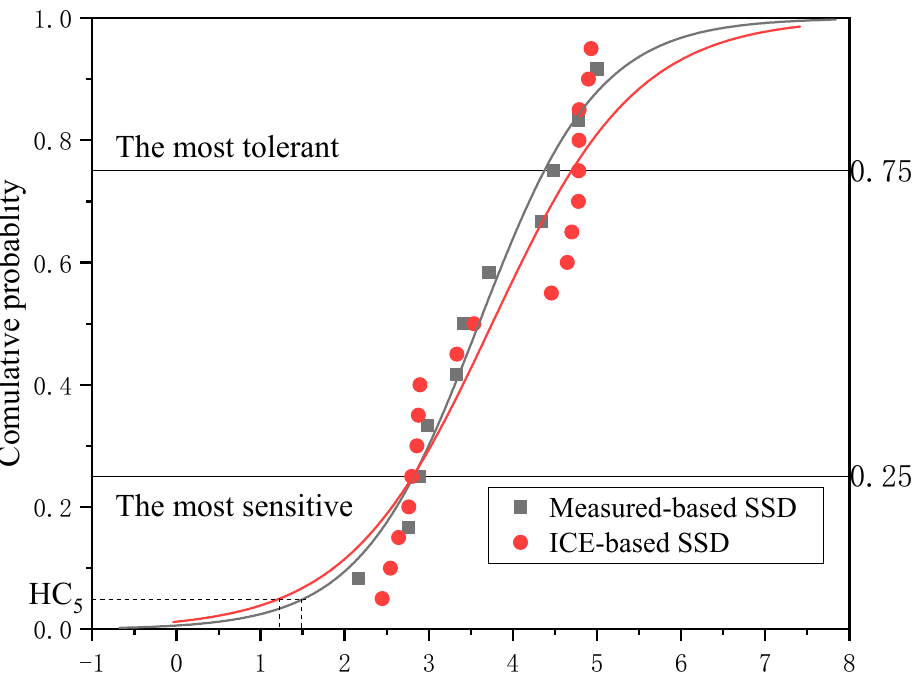
Figure 1. Comparison of SSDs constructed using measured toxicity data and ICE predicted toxicity data from 3 surrogate species.